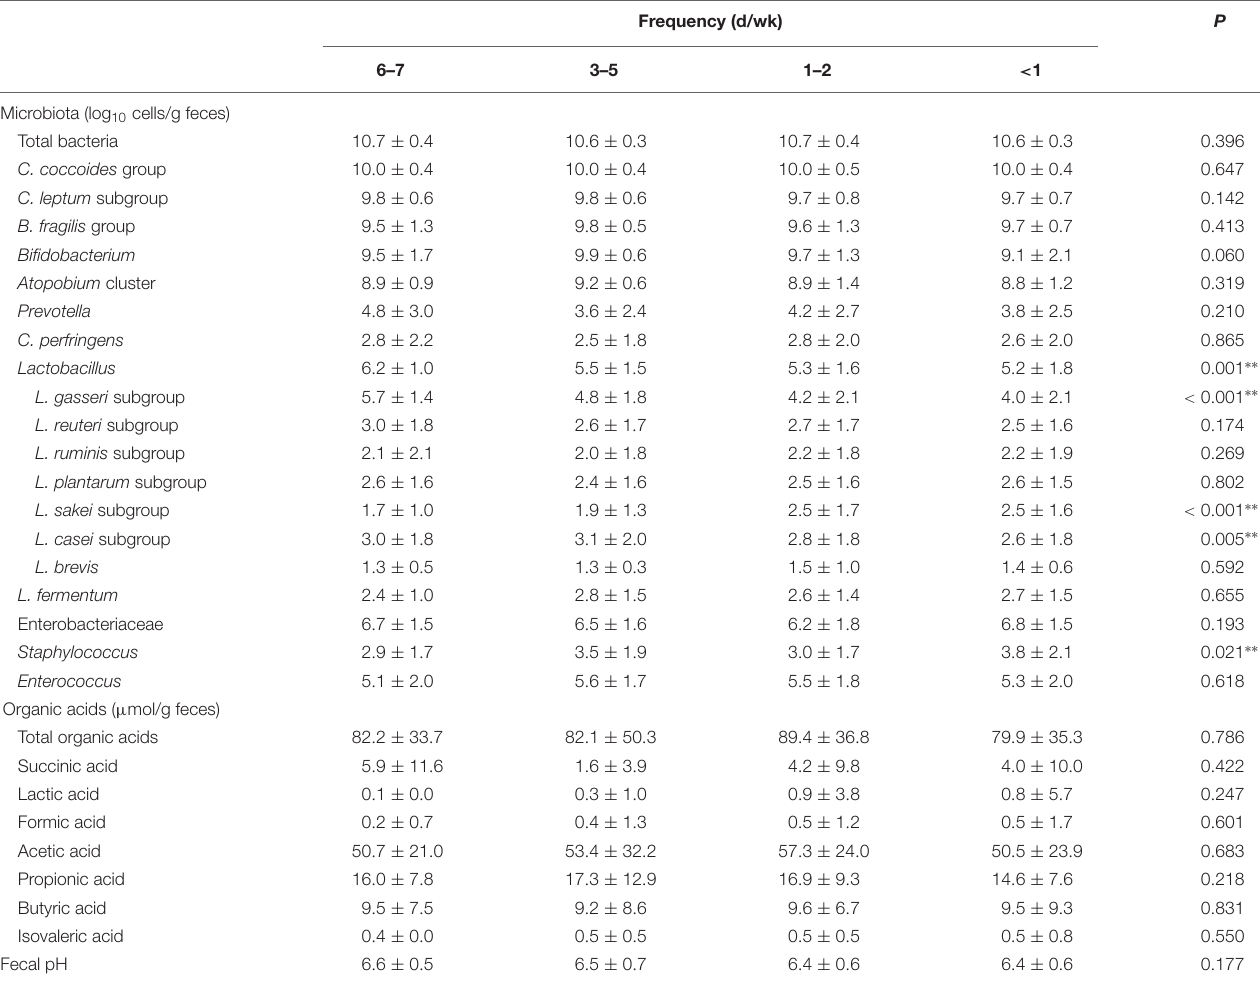
TABLE 3 | Fecal microbiota, organic acids and pH in relation to the frequency of yogurt consumption in healthy Japanese young adults ( n =